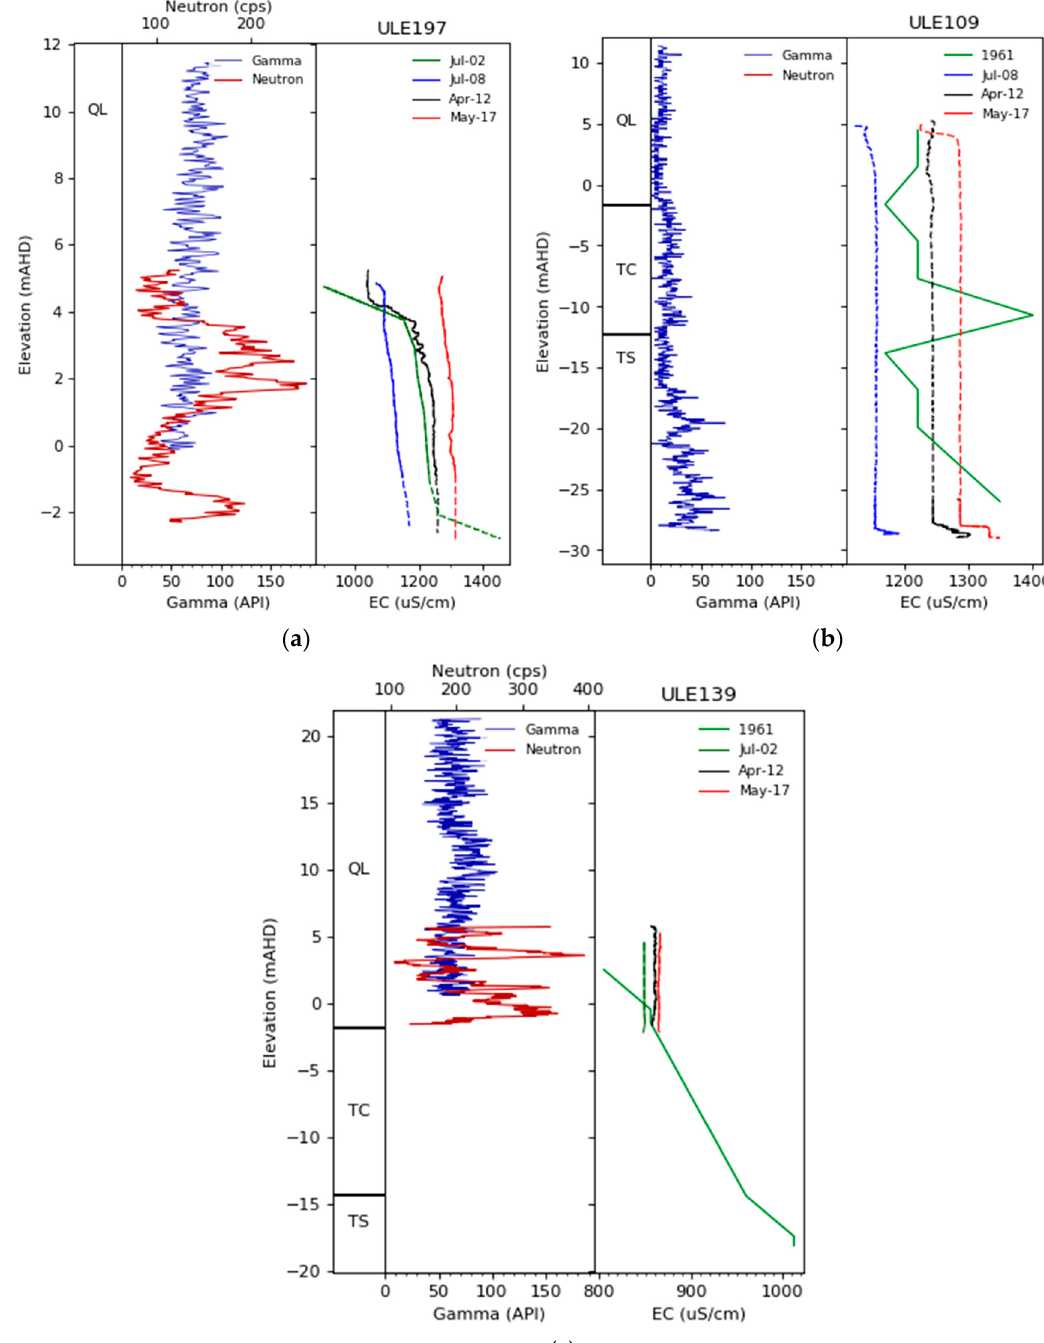
Figure 7. Gamma, Neutron, and EC profiles for ( a ) ULE197 (QL), ( b ) ULE109 (TS), and ( c ) ULE139 (QL) monitoring wells. The solid line indicates the EC of the production zone.